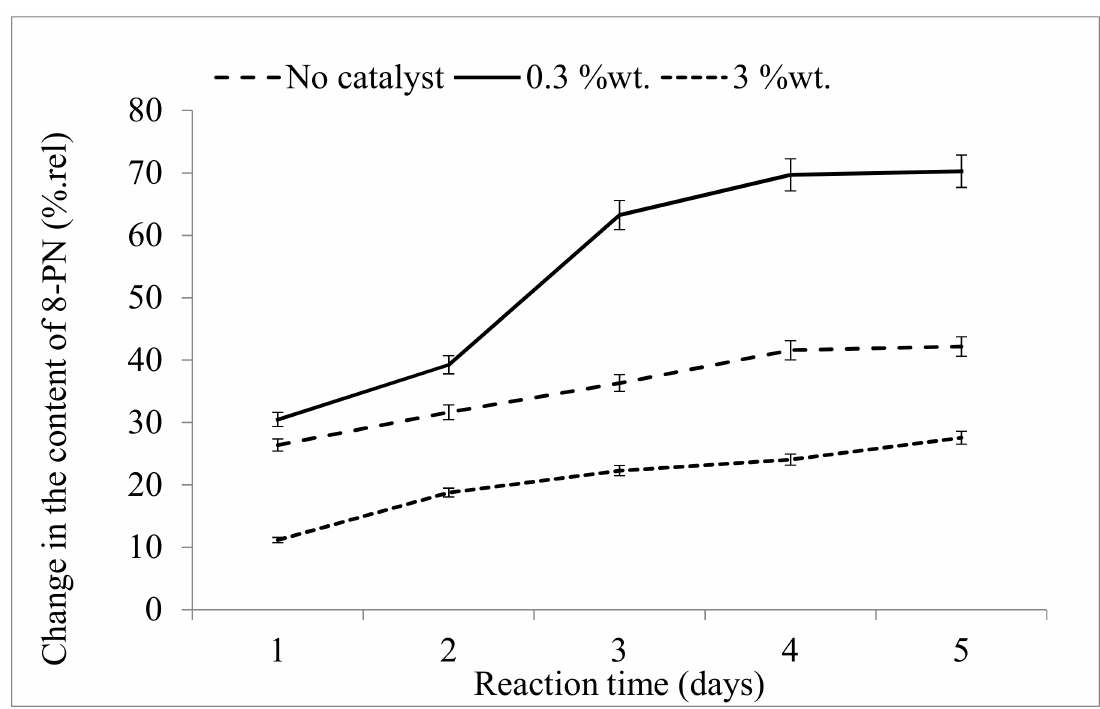
Figure 5. Catalyst-dependent changes in the content of 8-prenylnaringenin (8-PN) relative to the content in starting material.